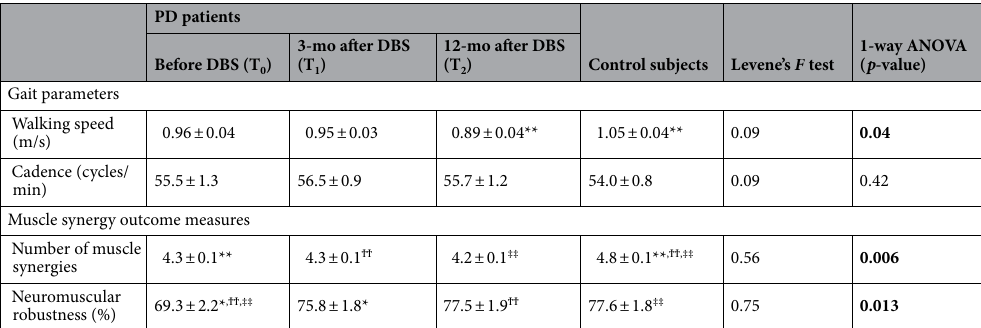
Table 2. Gait and muscle synergy analysis parameters for PD patients and controls during locomotion. Parameters’ values are reported as mean ± standard error over the sample population. Groups: PD patients before DBS (T 0 ), PD patients at 3 months after DBS (T 1 ), PD patients at 12 months after DBS (T 2 ), and controls. Statistically significant differences among groups are represented through asterisks (* p < 0.05; ** p < 0.01), daggers ( Ϯ p < 0.05; ϮϮ p < 0.01), and double daggers ( ‡ p < 0.05; ‡‡ p < 0.01). Significant values are